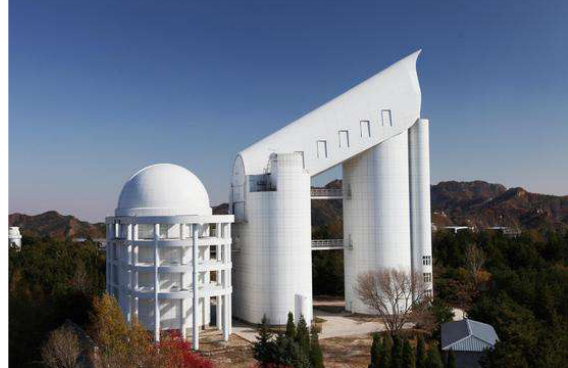
Figure 4. LAMOST telescope at the Xinglong Observatory of NAOC.